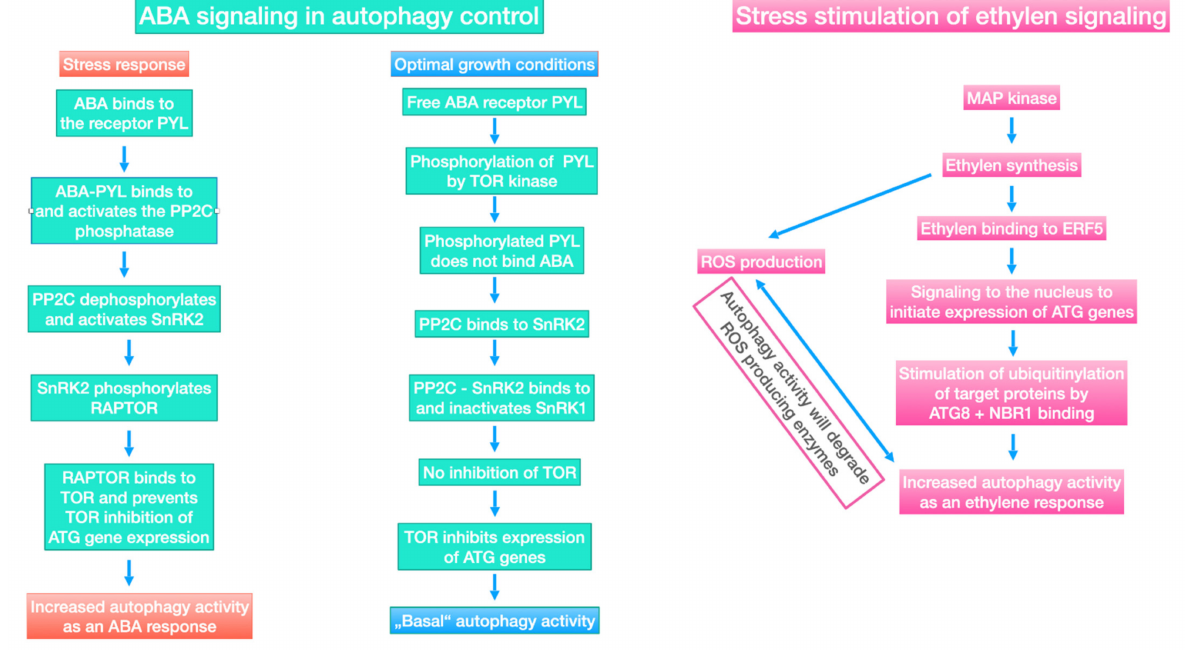
Figure 7. Autophagy control by stress stimulated ABA and ethylene signaling. Autophagy genes can be transcriptionally activated by ABA and ethylene signaling during nutrient starvation as well as environmental stress. On the left, the figure shows how ABA signaling is modified under stress. The right column shows the signaling pathway, leading to ethylene mediated stimulation of autophagy activity. Abbreviations: ATG8: Autophagy-related protein 8; COST1: Constitutively stressed 1, a protein attenuating autophagy by interacting with the autophagy adaptor protein ATG8E; RAPTOR: Regulatory-associated protein of TOR, an adaptor protein; TOR: Target of ra- pamycin, a serine/threonine protein kinase; TSPO: An 18 kDa translocator protein required to alter the autophagy-lysosomal